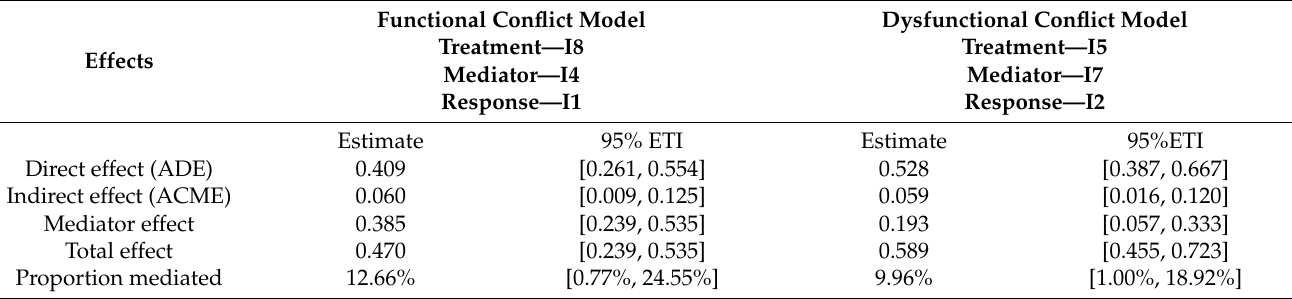
Table 6. Mediation